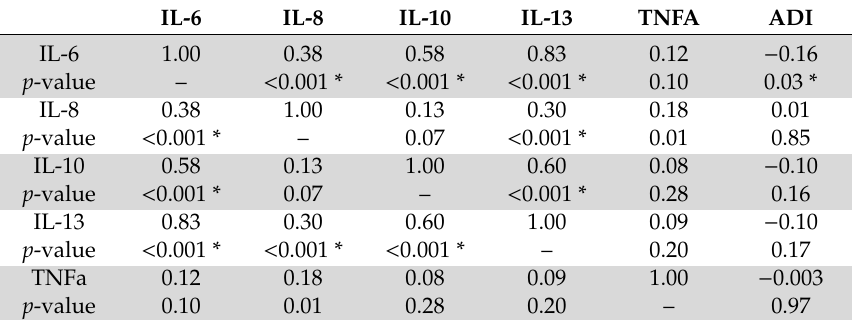
Table 4. Cytokine correlation matrix.